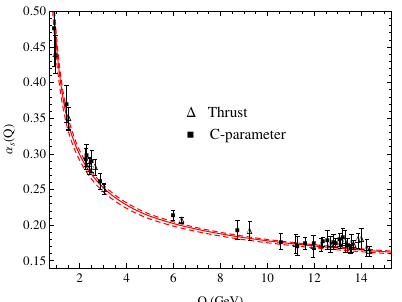
Figure 5. The extracted QCD coupling α s ( Q 2 ) from the thrust and C -parameter mean values by comparing PMC predictions with the JADE and OPAL data [41,58]. The error bars are the squared averages of the experimental and theoretical errors. The three lines are the world average